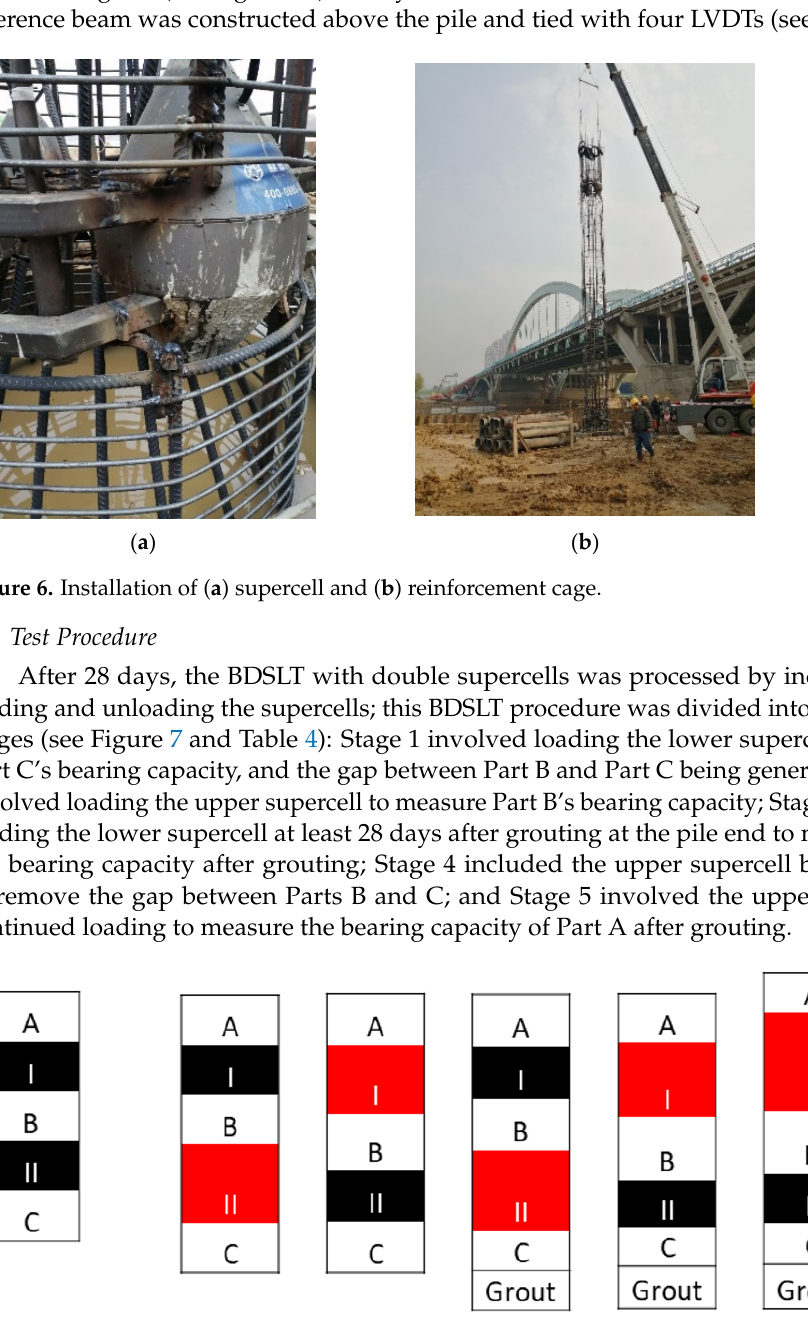
Figure 7. Locations of double supercells installed, separating the piles in Parts A, B and C (supercells are marked as red). Table 4. Procedure and purposes of the BDSLTs.